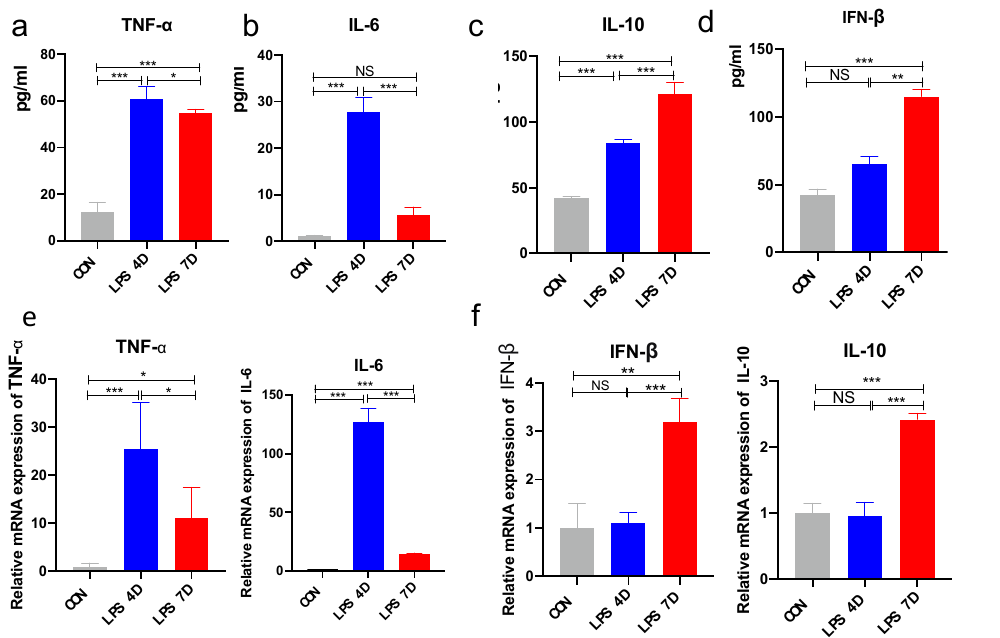
Figure 5. Neuroinflammatory response in hippocampal tissue of mice. ( a – d ) Expression of inflammatory factors TNF- α , IL-6, IL-4, and IL-10 in mice brains measured by ELISA. ( e , f ) mRNA expression of TNF- α , IL-6, IL-4, and IL-10. NS indicates no statistical difference from the control group. * p < 0.05, ** p < 0.03, *** p < 0.01 compared with control, n = 6 mice per group.